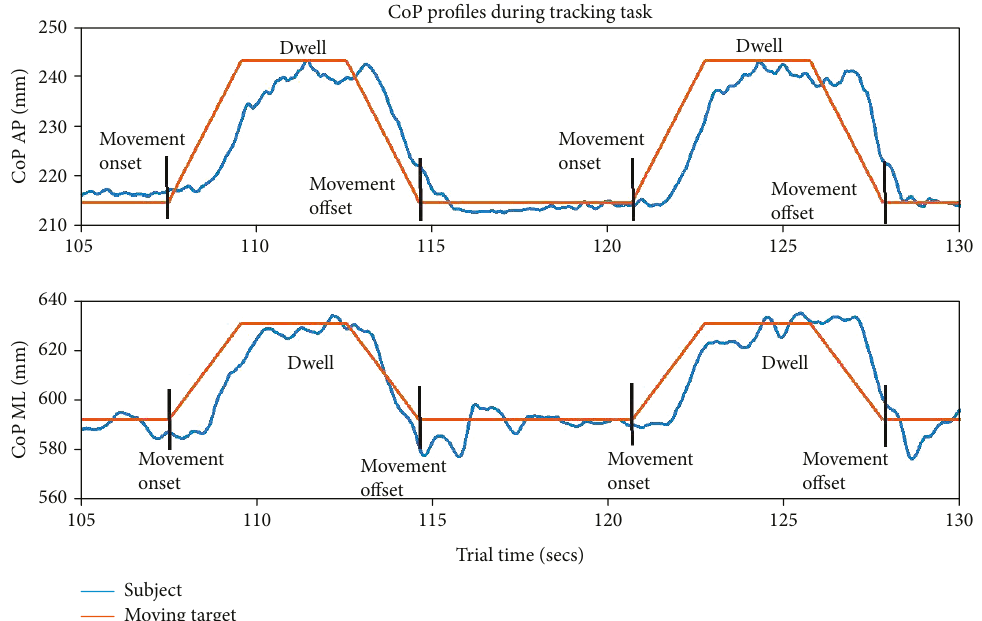
Figure 4: The sample CoP pro fi les of the subject (blue) and the moving circle (red) of the two consecutive leaning movements during the tracking task. The top panel displays the CoP pro fi les in the AP direction, while the bottom panel displays the CoP pro fi les in the ML direction. Each movement is considered a separate repetition, which consists of a movement onset, dwell period, and movement o ff set. Movement onsets are indicated as the time point in which the moving circle initiates movement from the nominal starting position to the end of the speci fi ed path. Upon reaching the end of the speci fi ed path, the moving circle dwells there for 3 seconds. When the dwell period ends, the moving circle returns to the nominal position and remains there until it initiates travel along the next path. The fi rst time point at which the moving circle acquires the nominal starting position on the return is the movement o ff set. Based on the orientation of the laboratory coordinate system, postural adjustments in the forward direction are indicated as CoP increasing from the nominal AP starting position. The postural shifts towards the left are indicated as CoP increasing from the nominal. Thus, in both repetitions, the ML subject was tracking the moving circle in the forward-left